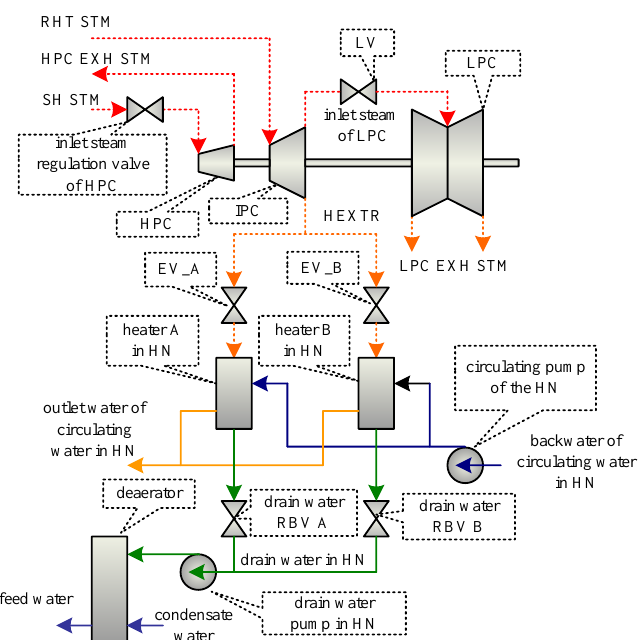
Figure 1. Schematic of thermodynamic system of turbine and heating supply parts in a typical CHP plant.